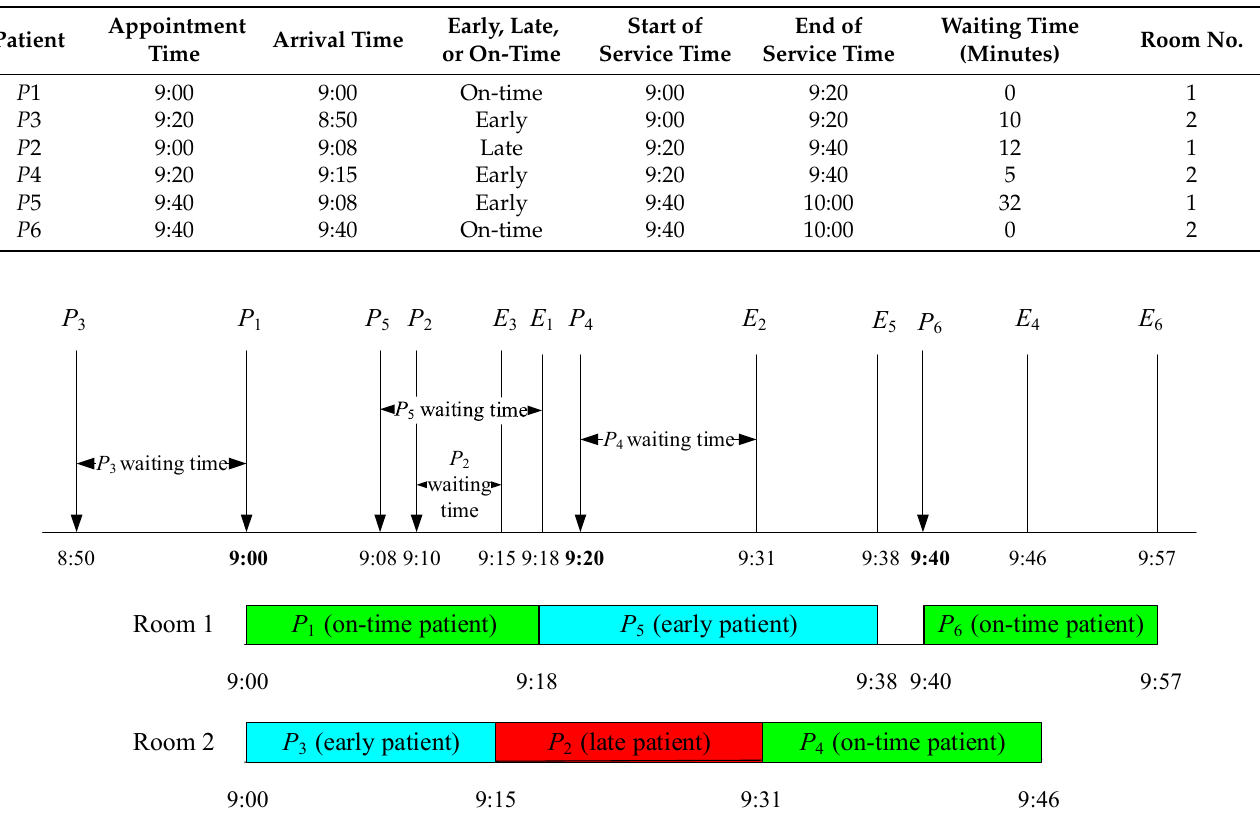
Figure 2. Examples of the preempt policy with constant service time.